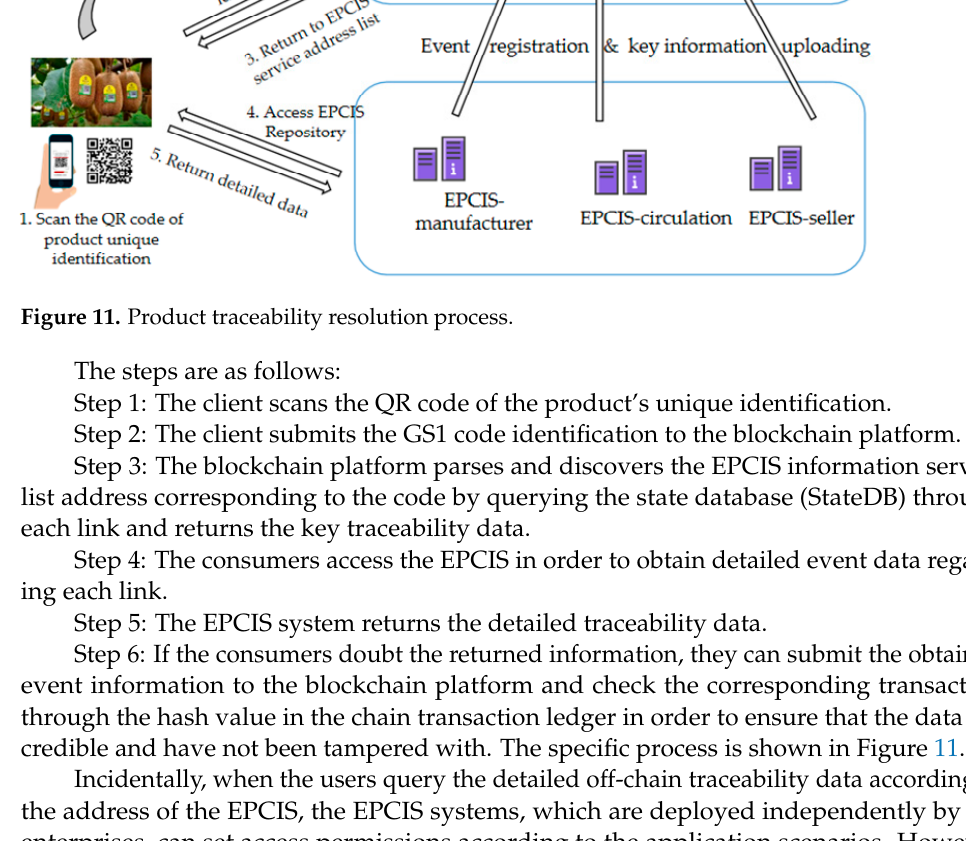
Table 6. Hyperledger fabric software environment.